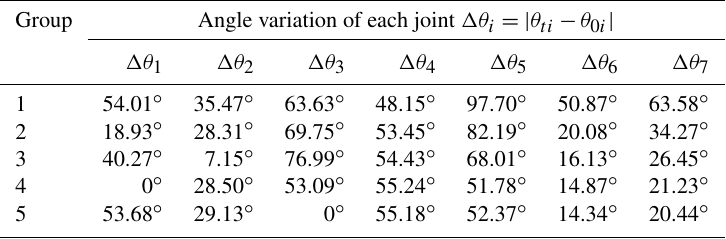
Table 4. Comparisons of joint motions with different motion priorities.